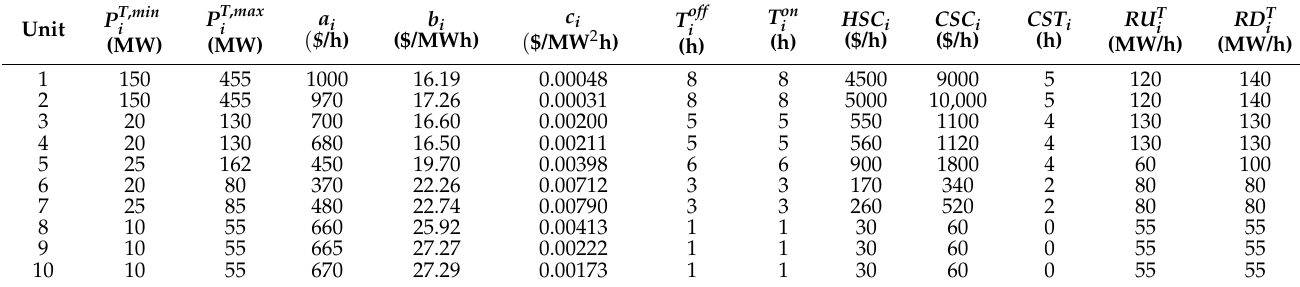
Figure 4. Schematic of the presented framework. Table 1. Characteristics of the conventional thermal power plants.